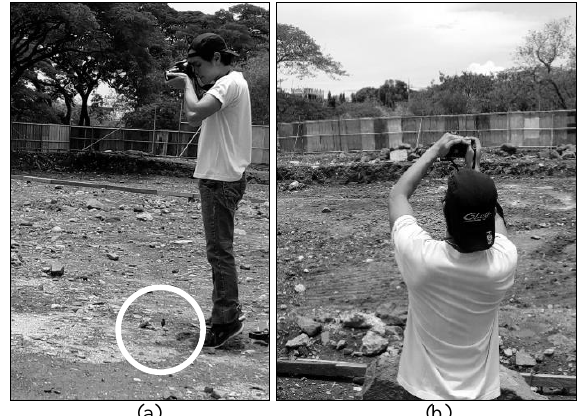
Figure 3. Site image acquisition: (a) camera over a GCP, using a plumb bob; and (b) image taken a few steps back from GCP